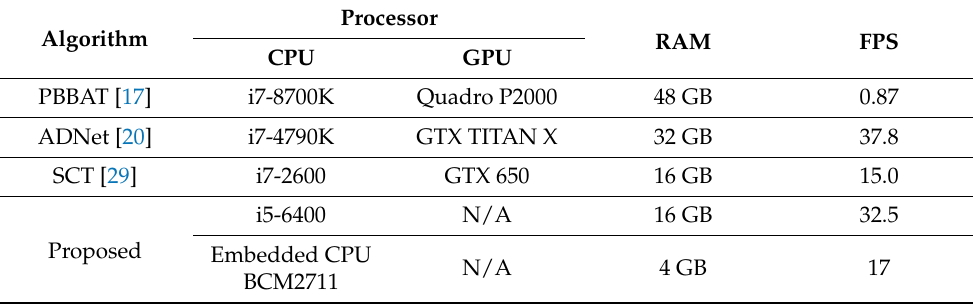
Table 3. Hardware specifications and FPS